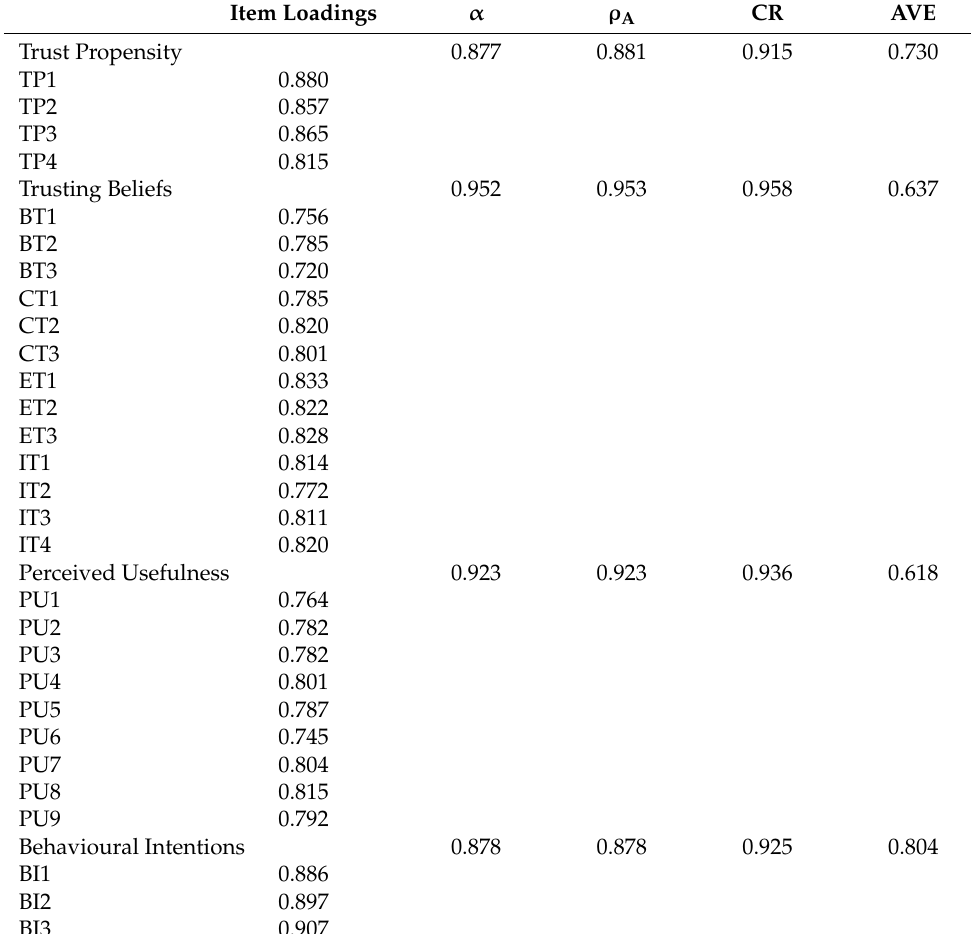
Table 4. Factor Loadings, reliability and validity.